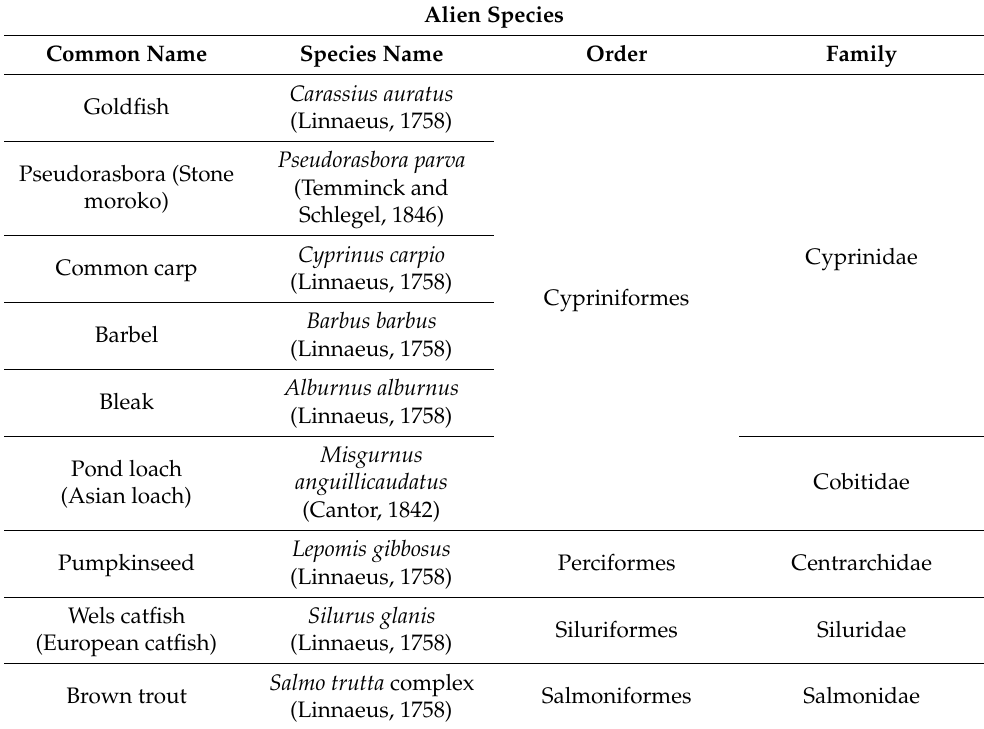
Table 3. Alien species sampled during the field